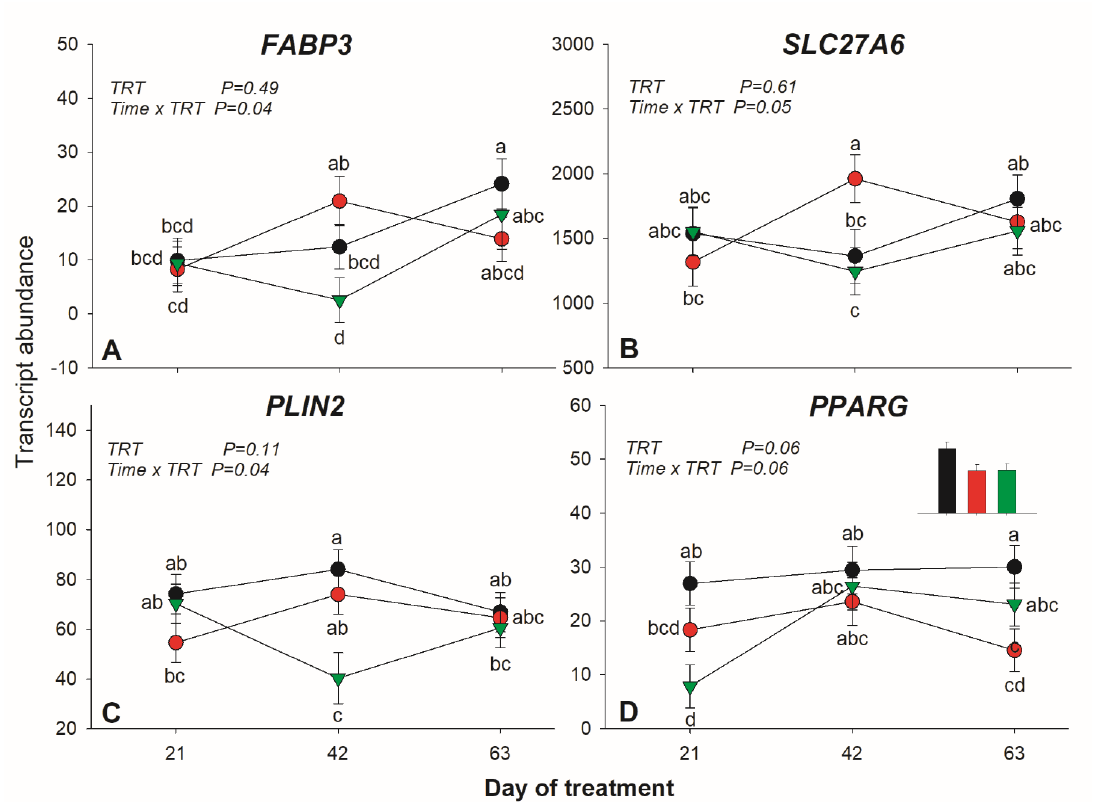
Figure 3. Transcription patter of genes affected by treatment × time interaction in adipose tissue of lactating dairy cows (n = 5/group) receiving a long-term supplementation of soybean oil or fish oil. p -value of the overall treatment (TRT) and TRT × Time interaction is reported. A = F ABP3 , B = SLC27A6 , C = PLIN2 and D = PPARG . Data were corrected for the baseline before statistical analysis. Bars denote standard error of the means.